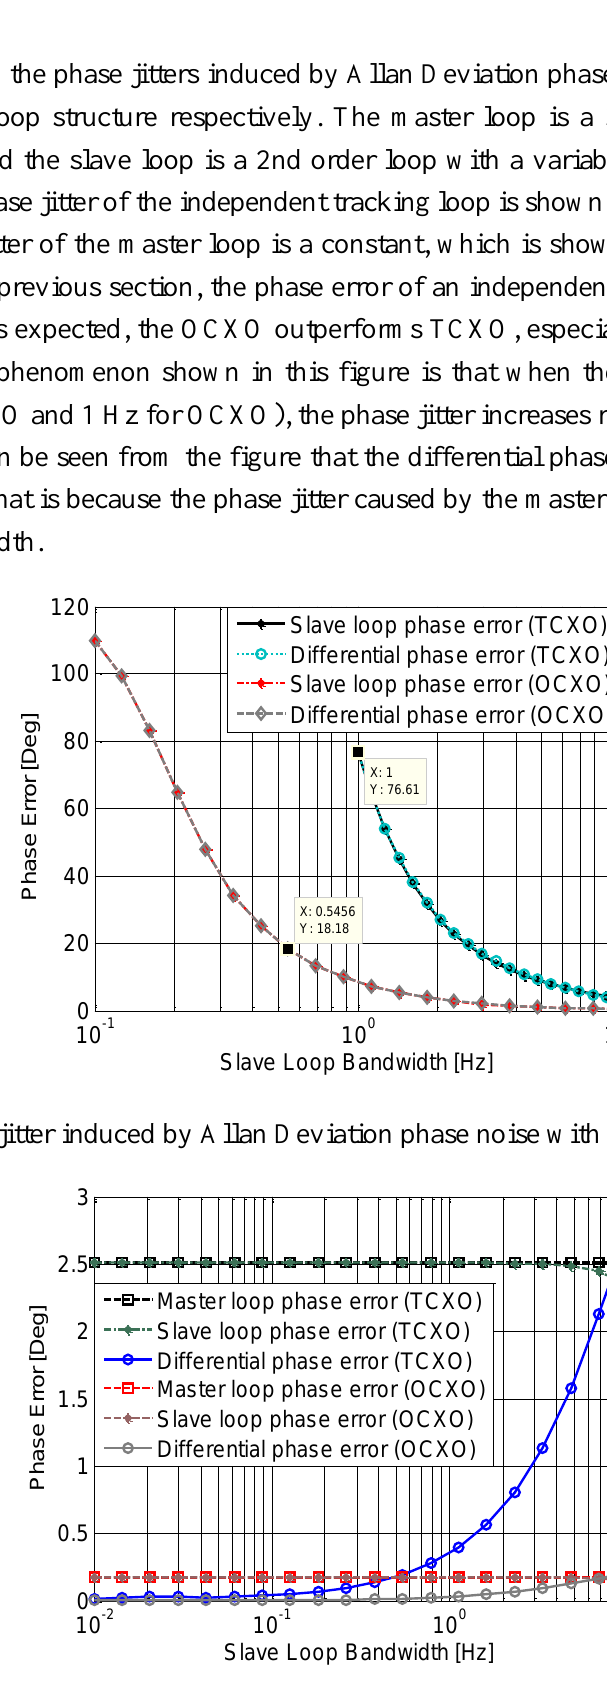
Figure 9. Phase jitter induced by Allan Deviation phase noise with an assisted